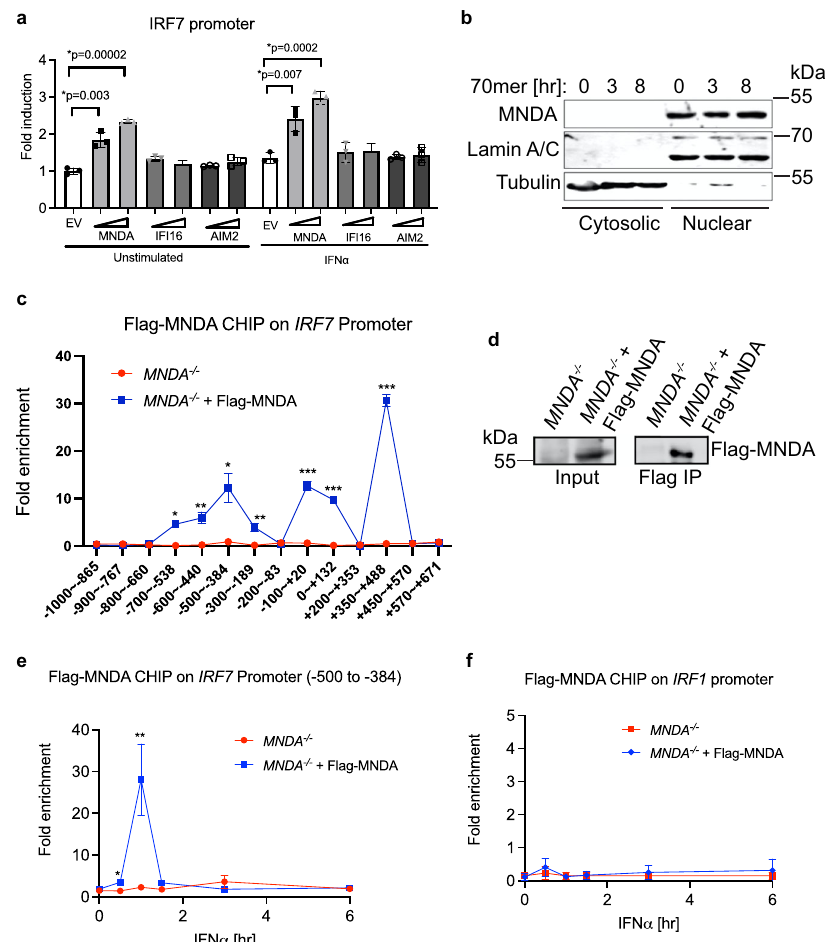
Fig. 7 MNDA is recruited to the IRF7 promoter after IFN stimulation. a Assessment of the effect of expression of PYHIN proteins on IRF7 promoter induction by reporter gene assay. HEK293T cells were transfected with pCMV-HA empty vector (EV) or the same vector expressing MNDA, IFI16 or AIM2 for 24 h prior to stimulation with IFN α (1000 U/ml) for a further 24 h. Data are mean ± SD of triplicate samples and are representative of three independent experiments; two tailed unpaired Students t test; * p < 0.05 indicates signi fi cance compared to respective groups. b Analysis of subcellular expression of MNDA protein by immunoblot of lysates from THP-1 cells transfected with dsVACV 70mer (1 μ g/ml) for the indicated times. Cytoplasmic and nuclear fractions generated were immunoblotted for the indicated proteins. Representative of three experiments. c ChIP of the recruitment of Flag- MNDA to the IRF7 promoter between the region of nucleotides − 1000 to + 671, using primer sets to amplify the speci fi c regions indicated, in MNDA − / − cells expressing empty lentiviral vector or vector encoding Flag-MNDA. Cells were stimulated with IFN α (1000 U/ml) for 1 hr. d Anti-Flag immunoprecipitation (IP) and immunoblot analysis of Flag-MNDA protein from ( c ). e , f ChIP of the recruitment of Flag-MNDA to the − 500 to − 384 region of the IRF7 promoter ( e ) or the IRF1 promoter ( f ) in MNDA − / − cells expressing empty lentiviral vector or vector encoding Flag-MNDA. Cells were treated with IFN α (1000 U/ml) for the indicated times. For ( c , e , f ), data are presented as mean ± SEM of three independent experiments, each done with technical duplicates; two tailed unpaired Students t test; * p < 0.05 indicates signi fi cance compared to respective groups; p values for ( c ) are * p = 0.001, ** p = 0.003, *** p = 0.00001; p values for ( e ) are * p = 0.04, ** p = 0.01. ChIP antibody isotype controls for ( c , e , f ) are shown in Supplementary Fig.